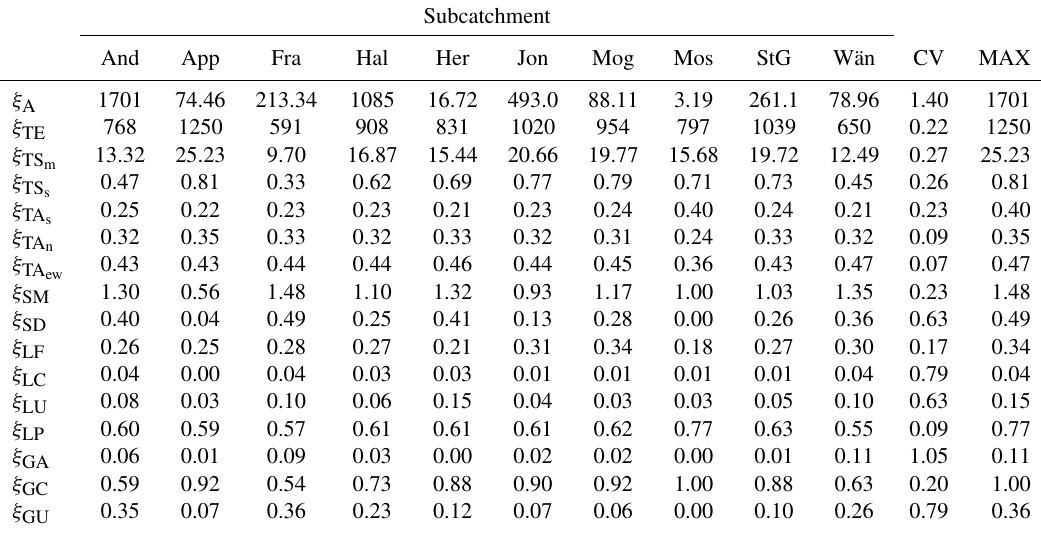
Table 5. Values of the subcatchment characteristics. The names of the subcatchments are abbreviated using the first three letters and the symbols are reported in Table 2. The last two columns contain the coefficient of variation and the maximum value of each